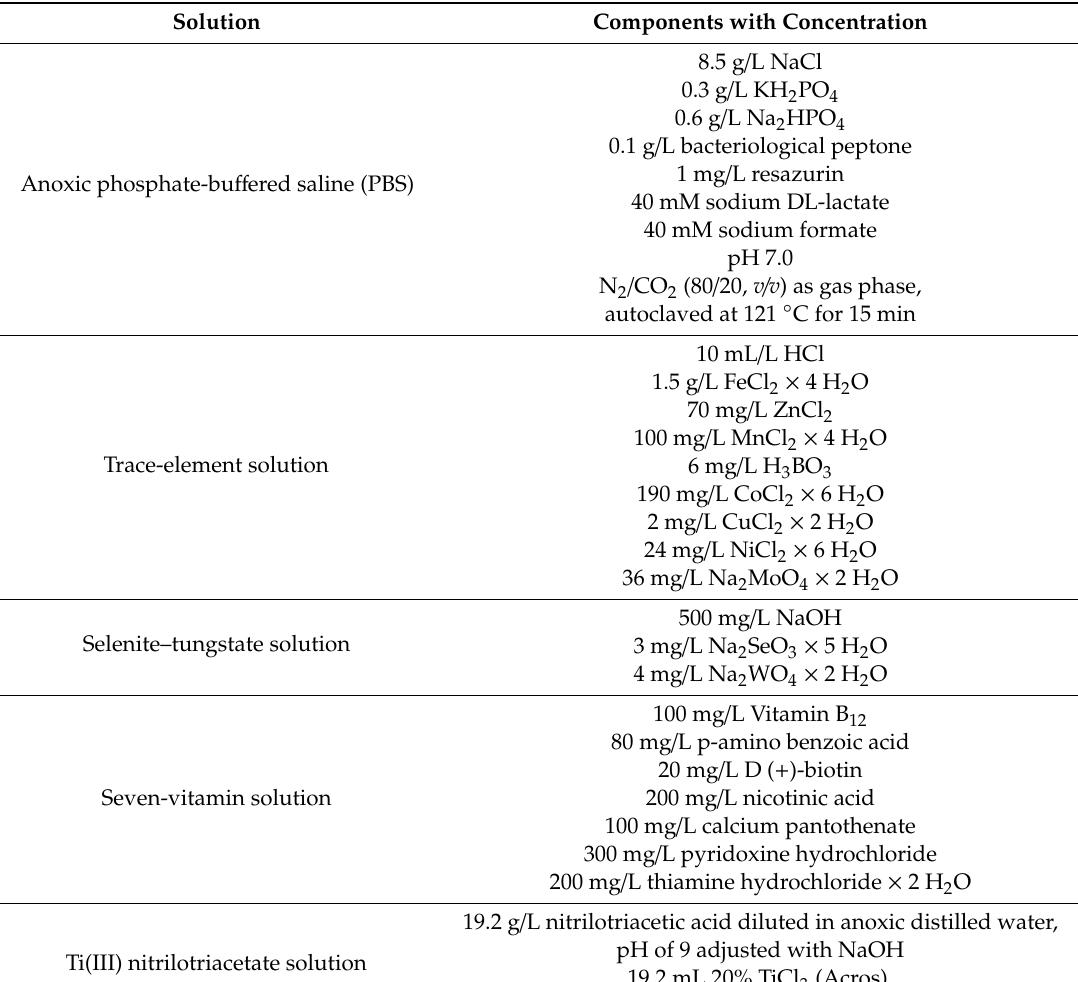
Table 4. Composition of solutions used. If not indicated otherwise, all solutions were prepared with pure distilled water (Ultra Clear, Siemens Water Technologies, Günsburg, Germany) and chemicals and solvents were purchased from Fluka (Muskrgon, MI,